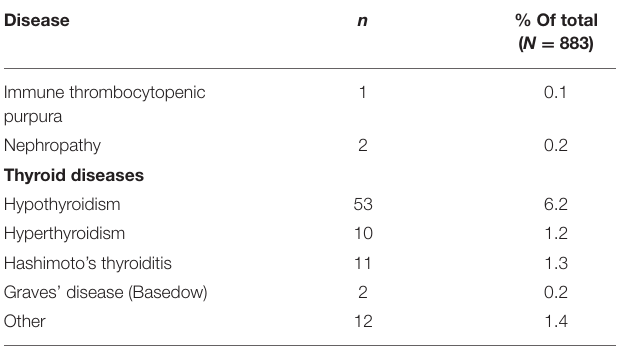
TABLE 4 | Concomitant disease by system organ class. TABLE 5 | Diseases of particular